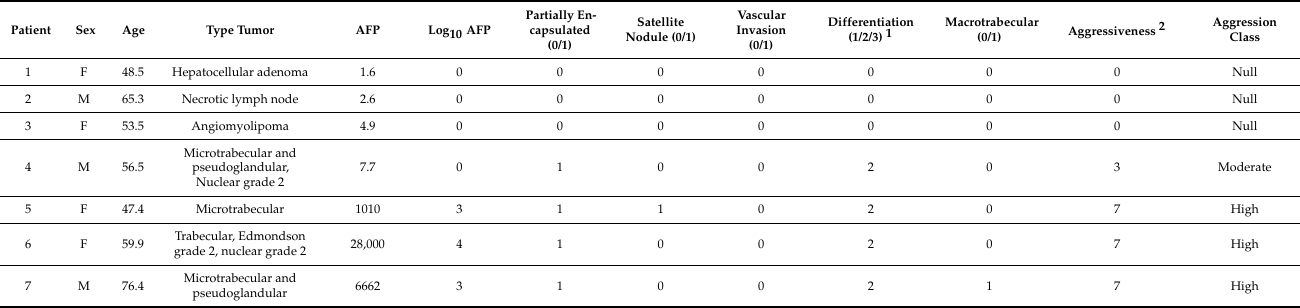
Table 1. Clinical characteristics of the